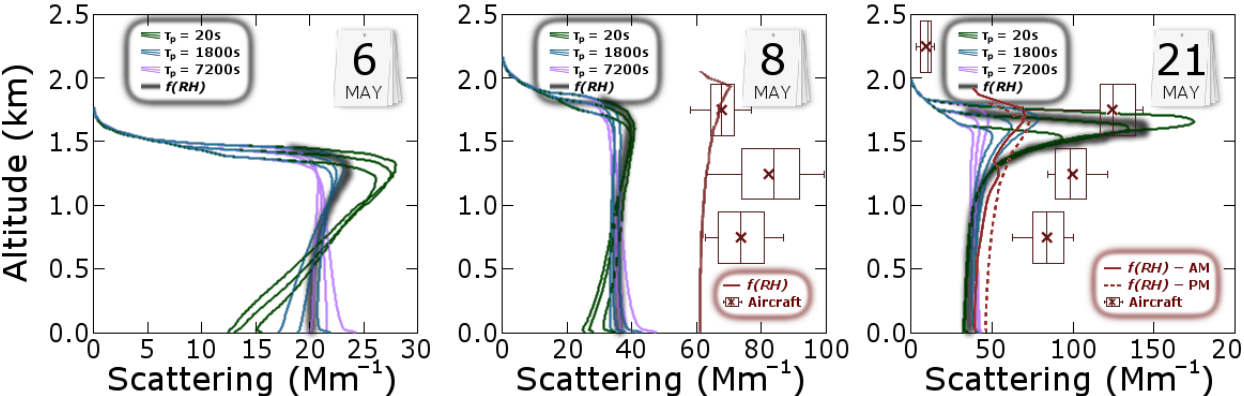
Fig. 8. Modelled scattering profiles for 6 May (left), 8 May (middle) and 21 May (right) at 550nm wavelength. Simulations with different partitioning timescales are shown in different colours. For each simulation the profiles of 13:30UTC, 14:30UTC and 15:30UTC are shown. The f (RH) line shows the profile without repartitioning of ammonium nitrate (constant mixing ratios), with instant equilibrium for aerosol water, at 14:30UTC. For 8 and 21 May, data from Morgan et al. (2010) is shown in red (550nm wavelength), consisting of aircraft observa- tions and f (RH), which is based on observed scattering coefficient at the surface and observed relative humidity with an assumed power-law relationship between relative humidity and scattering